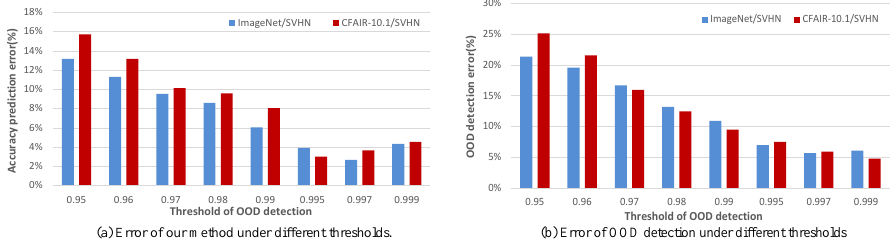
Figure 3. ( a ): The vertical axis represents the error between the model accuracy predicted by our method and the true accuracy of the classifier, while the horizontal axis represents the OOD detection threshold. This error decreases initially and then increases as the OOD threshold increases. ( b ): The vertical axis represents the error of OOD detection, while the horizontal axis represents the OOD detection threshold. This error decreases as the OOD threshold increases. The ID/OOD data in the dataset comes from CIFAR-10.1/ImageNet and ImageNet/SVHN, respectively. The ratio of ID data to OOD data is 9:1.